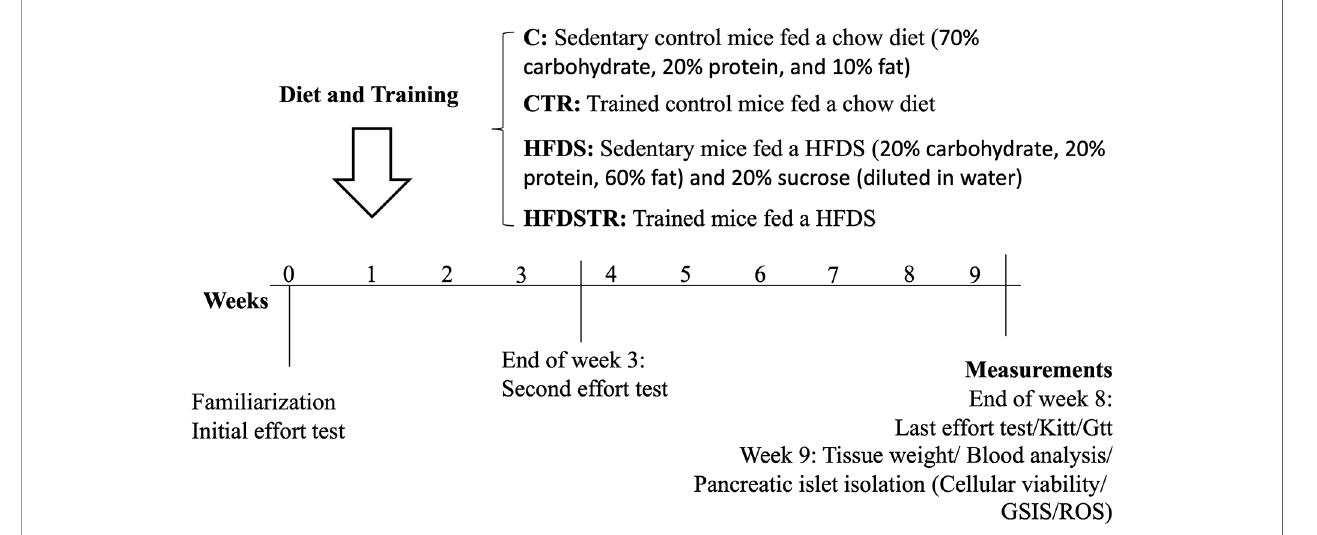
FIGURE 1 | Schematic representation of the experimental